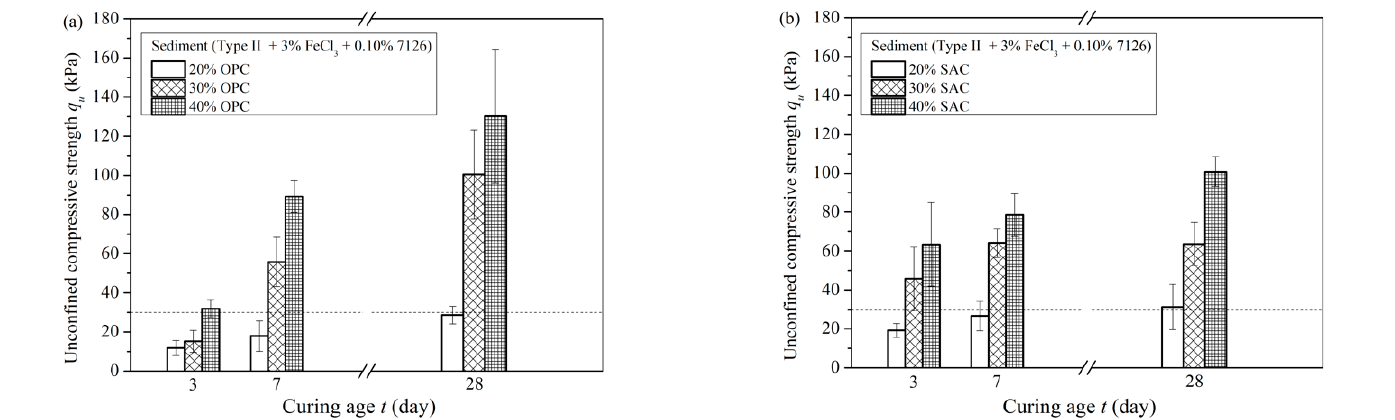
Figure 9. Unconfined compressive strength of the solidified sediment after compound pretreatment. ( a ) OPC. ( b ) SAC.